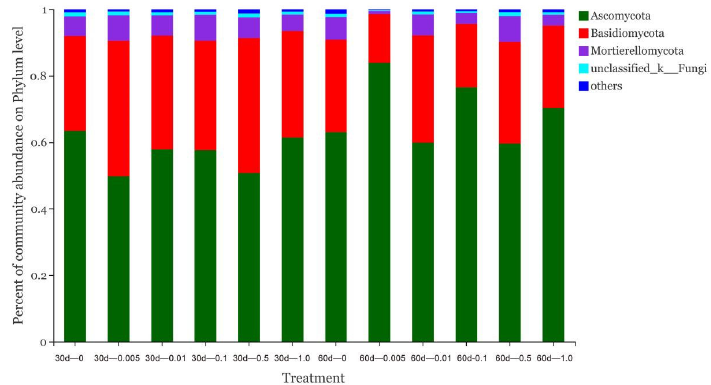
Figure 6. Effect of pyrogallic acid on fungal community composition.